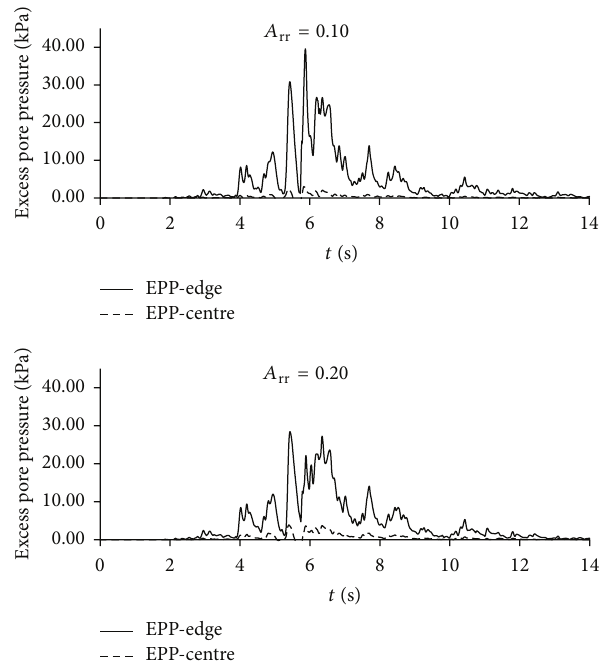
Figure 10: Excess pore-pressure time histories at the center and at = 0.10 and 𝐴 = 0.20 the edge for 𝐴 rr rr